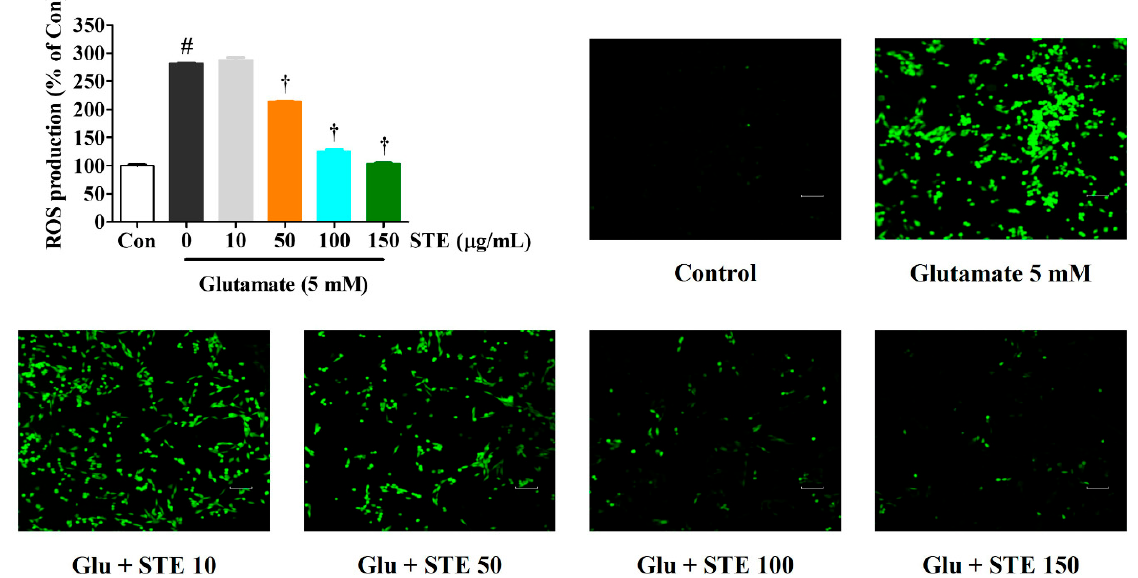
Figure 2. Effects of Selaginella tamariscina ethanol extract (STE) against glutamate-induced intracellular reactive oxygen species (ROS) production in HT22 cells. Cells were pretreated with STE